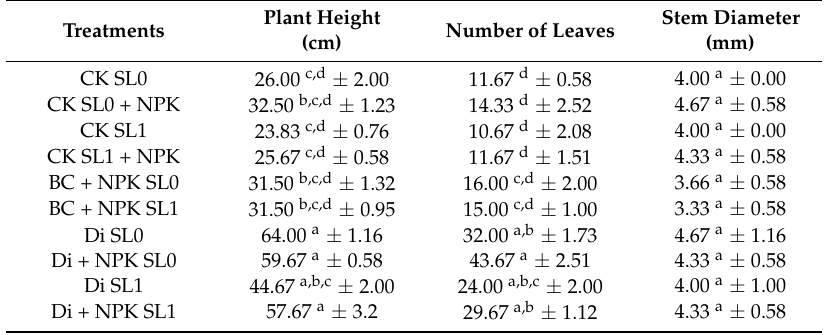
Table 6. Mean ( ± Standard deviation) growth parameters of melon plants at the flowering stage.